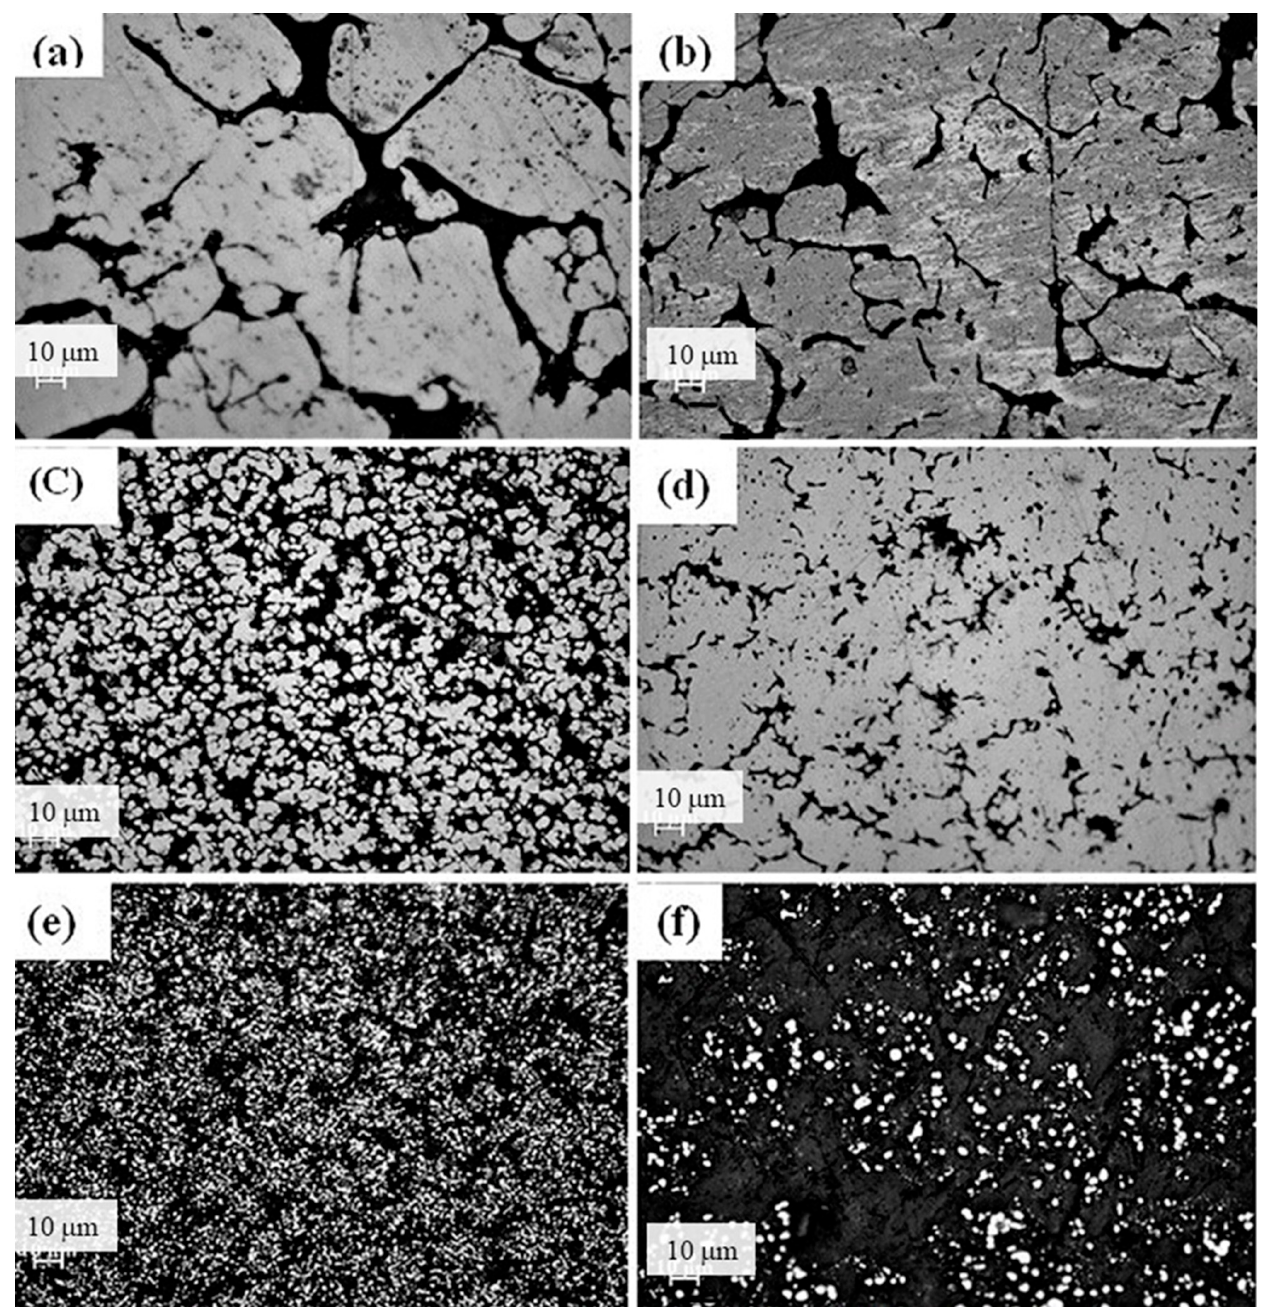
Figure 7. RLM photomicrographs of nanosized metal oxides reduced with H 2 at 800 and 1000 °C: ( a , b ) NiO; ( c , d ) Fe 2 O 3 ; ( e , f ) WO 3 .